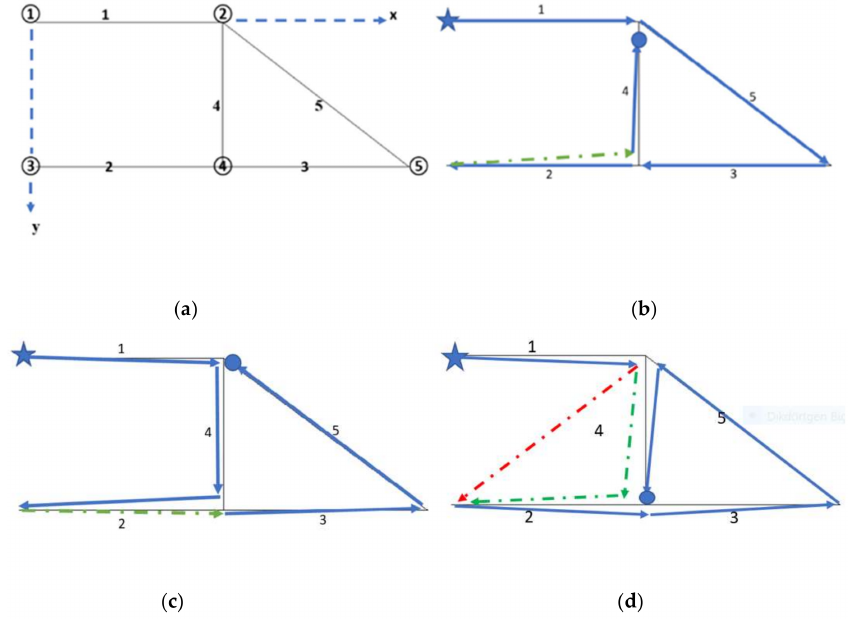
Figure 1. Five-wall, five-joint example. ( a ) Numberings of walls and nodes; ( b , c , d ) nozzle movements for Candidates 1, 2, and 3,